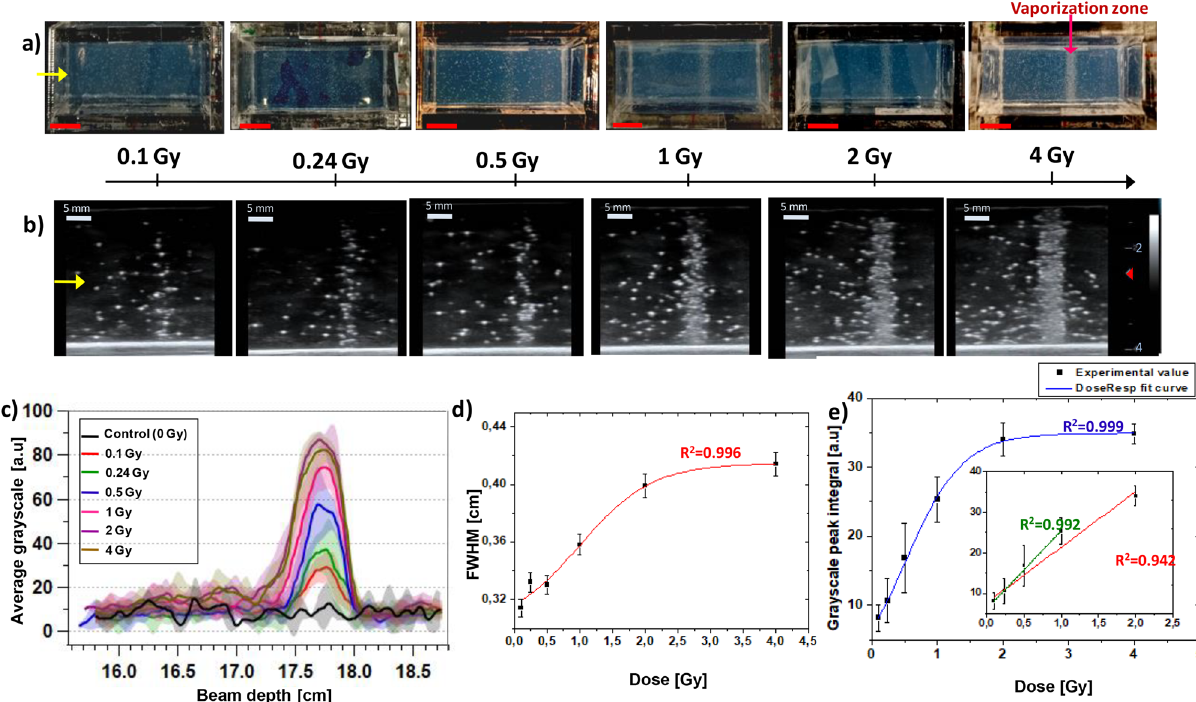
Figure 3. Dose effect of C-ions (312 MeV/u, 180 mm range) on the triggered vaporization of PVA/PFB NDs @ 37 °C: ( a ) Top-view photographs of independent phantoms of NDs dispersed in PAM (4 × 10 6 NDs/ml) post-irradiation at doses between 0.1 and 4 Gy (the red scale bars correspond to 10 mm); ( b ) corresponding depth-resolved US images (7.5 MHz, MI = 0.1) of the NDs phantoms at each dose, the yellow arrow indicates the C-ions beam’ entrance side (scale bars are 5 mm); ( c ) Comparison of the average grayscale value profiles of the US images at different doses as a function of the distance traveled by C-ions (beam depth), the shaded areas correspond to the standard deviation (n = 6). ( d ) Variation of the FWHM of grayscale peaks as a function of the received C-ions dose (the red line is a dose–response fit function). ( e ) Evaluation of the peaks integrals from the average grayscale profiles as a function of C-ions dose. The inset shows the linear regression fits in the intervals of 0.1–1 Gy (green) and 0.1–2 Gy